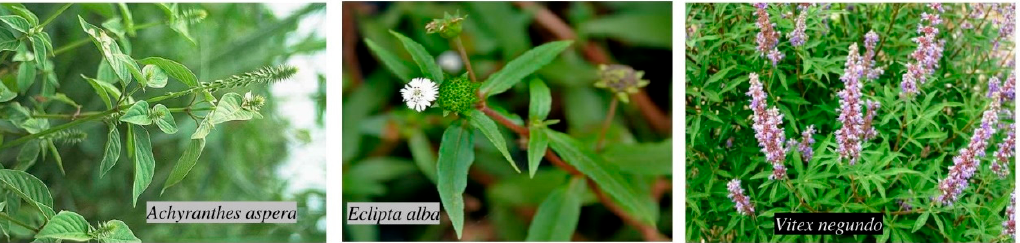
Figure 1. Photograph of selected samples.